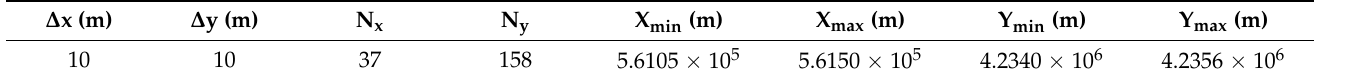
Table 2. Meshgrid features of the bathymetric